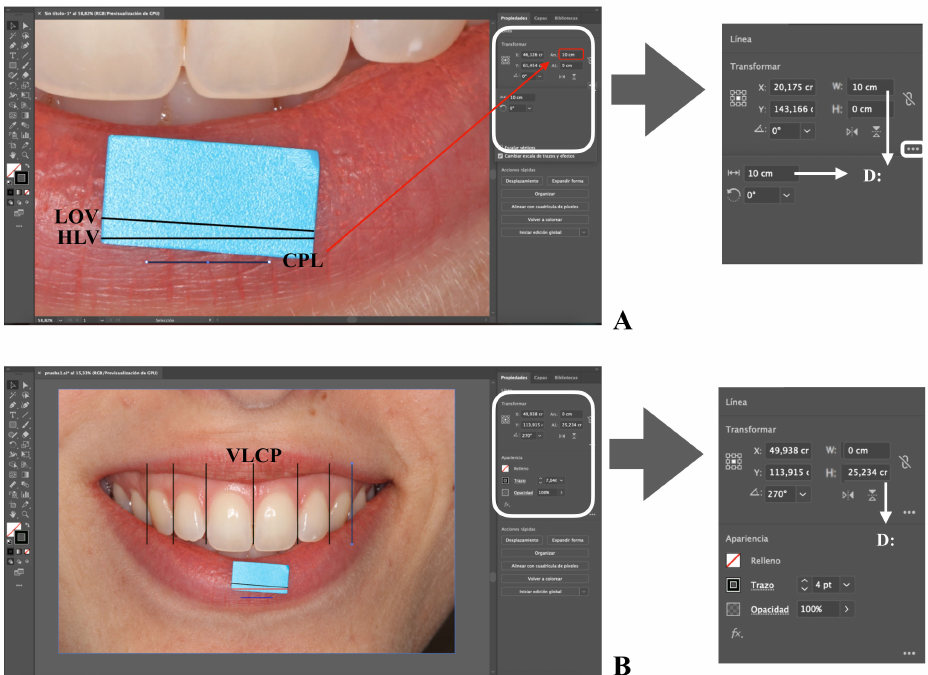
Figure 3. Screenshots of the sample image with the different steps of the protocol. LOV: line on the verifying witness. HLV: horizontal line on the verifying tab for scale. CPL: calibrated parallel horizontal line. VLVP: vertical line over contact point. D: distance. Screenshots of the sample image with the different steps of the protocol ( A , B